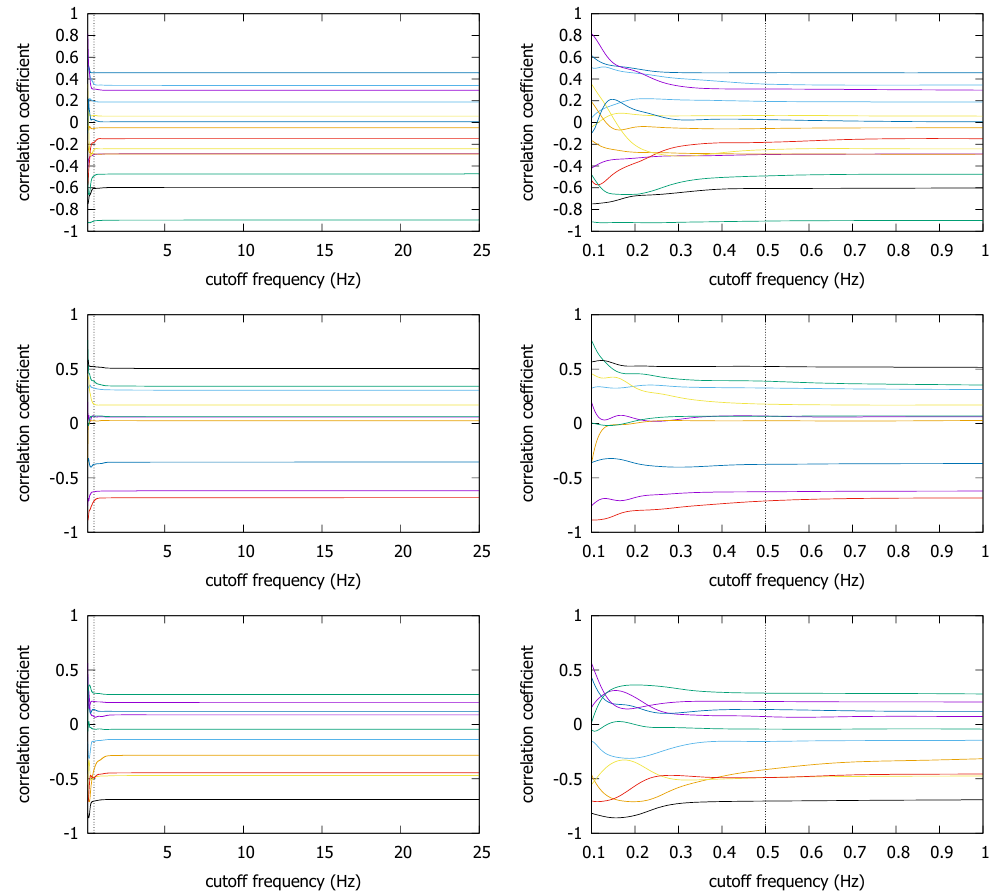
Figure 12. ρ max for non-coexistent trajectories from the three buildings in the Illinois dataset; CSL ( top ), Loomis ( middle ), and Talbot ( bottom ).